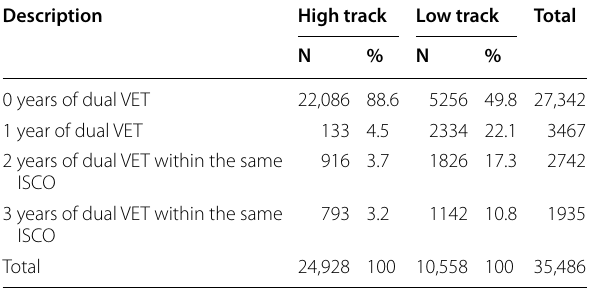
Data source: Geneva Schooling Database for 12 cohorts, 1993–2007